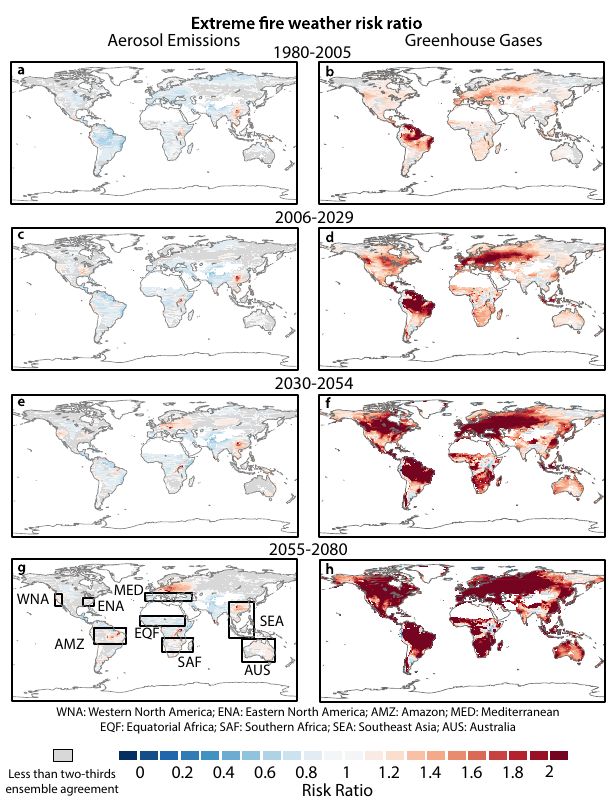
Fig. 1 Risk ratio of extreme fi re weather under different anthropogenic forcings. Risk ratio (RR) for 1980 – 2005 ( a , b ), 2006 – 2029 ( c , d ), 2030 – 2054 ( e , f ), and 2055 – 2080 ( g , h ) under aerosol (AER) ( a , c , e , g ) and greenhouse gas (GHG) ( b , d , f , h ) forcing. RR for each period is calculated as the probability of exceeding the 95th percentile of the baseline daily fi re-weather index (FWI) distribution in the all-forcing (ALL) ensemble divided by the probability of exceeding that same threshold in the all-but-one (X) forcing ensemble. The baseline FWI distribution for each period is the distribution of FWI in the ALL ensemble in that period. Regions in red (blue) have an increased (diminished) extreme fi re-weather risk under a single forcing. Grid points masked in gray have less than two-thirds ensemble agreement on whether the RR is greater or less than one. Oceans, glaciers, and bare land are masked in white. The boxed areas de fi ne the regions used for the regional analysis are labeled in panel g and are described in Supplementary Table 2.